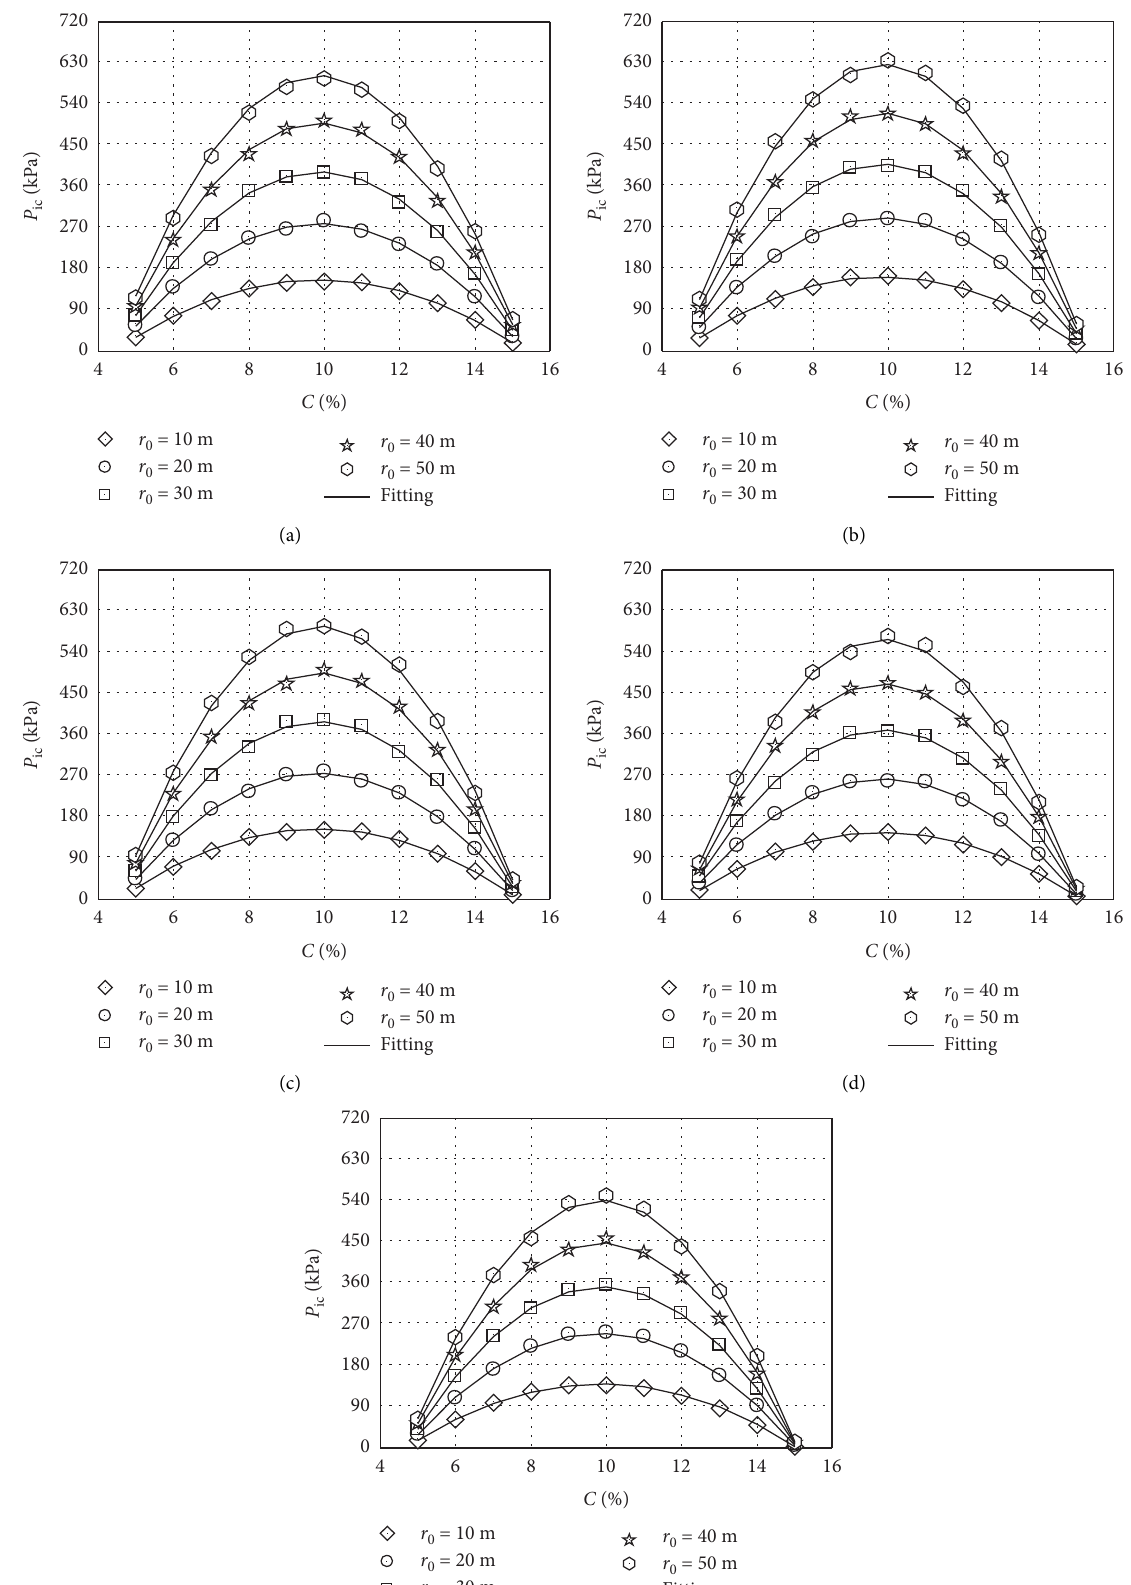
Figure 7: Relation between p ic and C under different initial temperature environment conditions. (a) T (d) T � +30 ° C. (e) T � +60 °